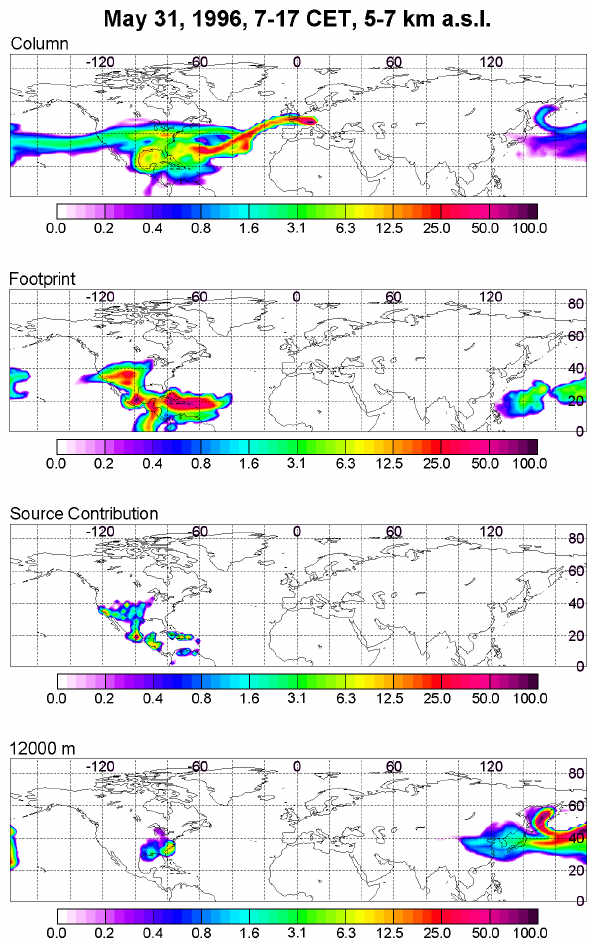
Fig. 2. FLEXPART fifteen-day backward (retroplume) simulation for 31 May 1996, 07:00 to 17:00CET and 5 to 7kma.s.l. above IMK-IFU; the panels show emission sensitivities (see Sect. 2.2). The maximum values of the different scales are uncertain and, therefore, not specified. The PBL source contribution was deter- mined by folding the footprint emission sensitivity (i.e., the emis- sion sensitivity for the lowest layer) with NO x emissions from the EDGAR inventory.